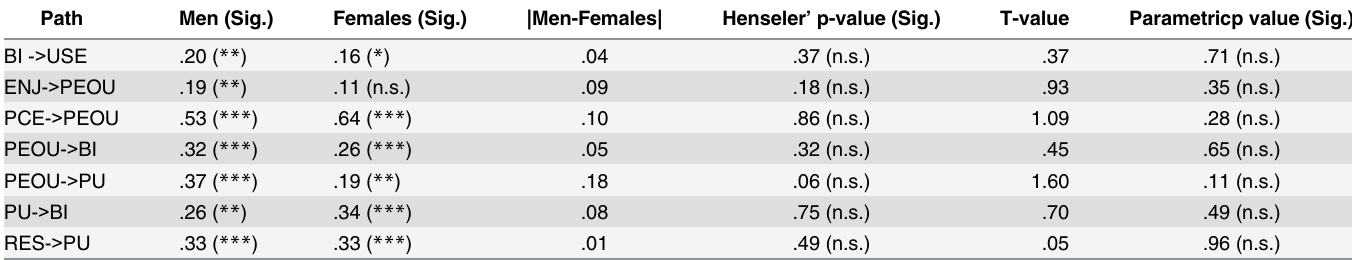
Table 5. Path coefficients. Path Men (Sig.) Females